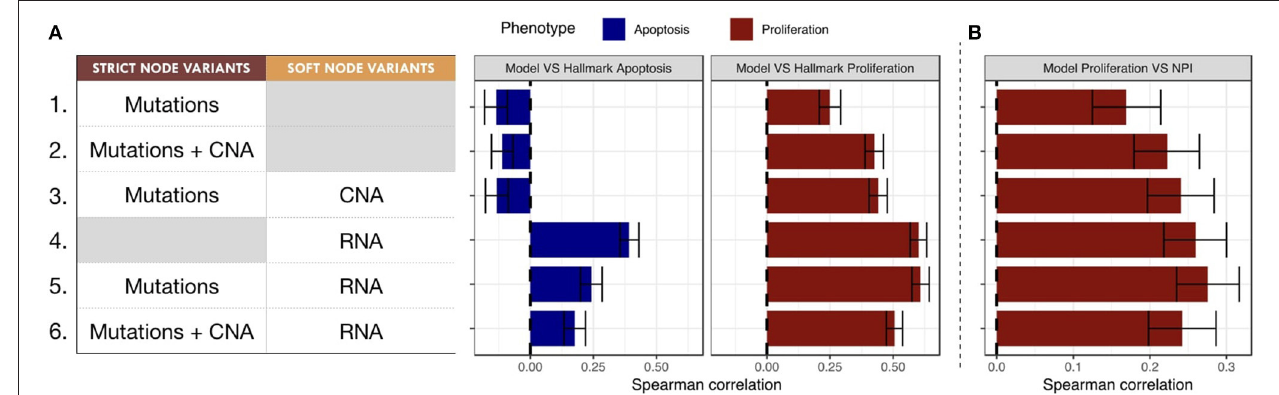
FIGURE 7 | Biological and clinical classification of phenotypic probabilities from personalized models. (A) Model personalization methods used and the corresponding Spearman rank correlation between phenotypic probabilities from personalized model and the corresponding Hallmark signatures score based on RNA gene sets. (B) Spearman rank correlation between personalized Proliferation probabilities and the Nottingham Prognostic Index (NPI) score based on clinical features (size and grade of tumor, node